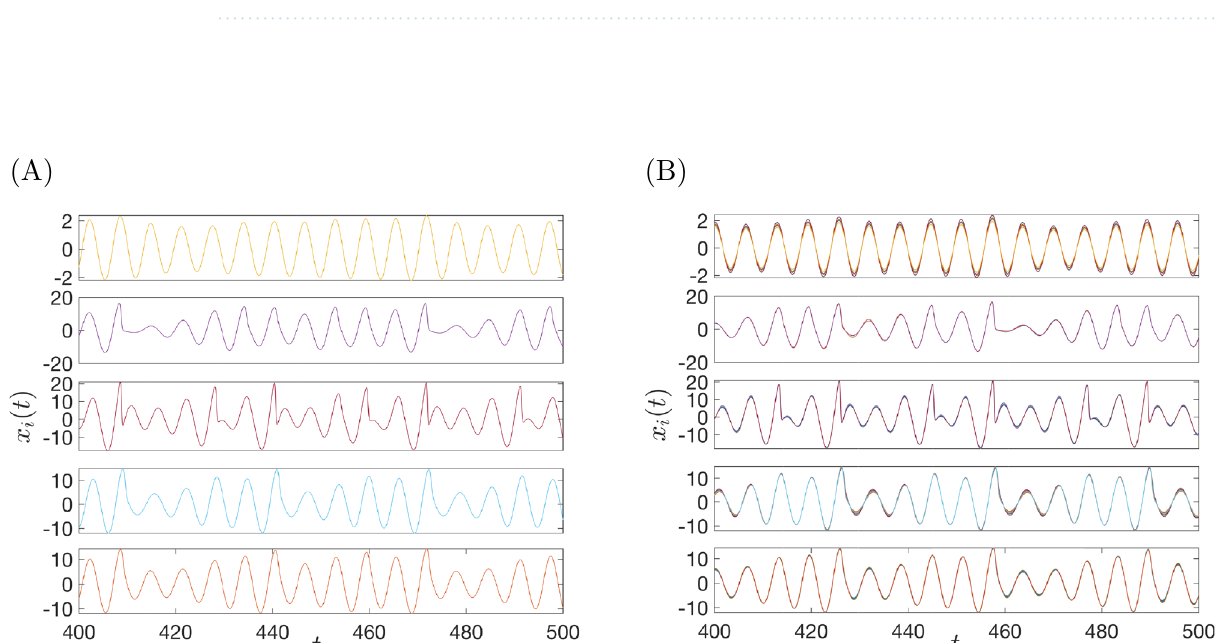
Figure 3. Dynamics of Rössler oscillators coupled according to the synthetic network in Fig. 2 : ( A ) when the network is unperturbed exact clusters synchronization is observed; ( B ) when the network is perturbed approximate cluster synchronization appears. From top to bottom, state variables x i ( t ) for i = 1, . . . , 10 (first panel); i = 11, . . . , 14 (second panel); i = 15, . . . , 21 (third panel); i = 22, . . . , 41 (fourth panel); i = 42, . . . , 50 (fifth